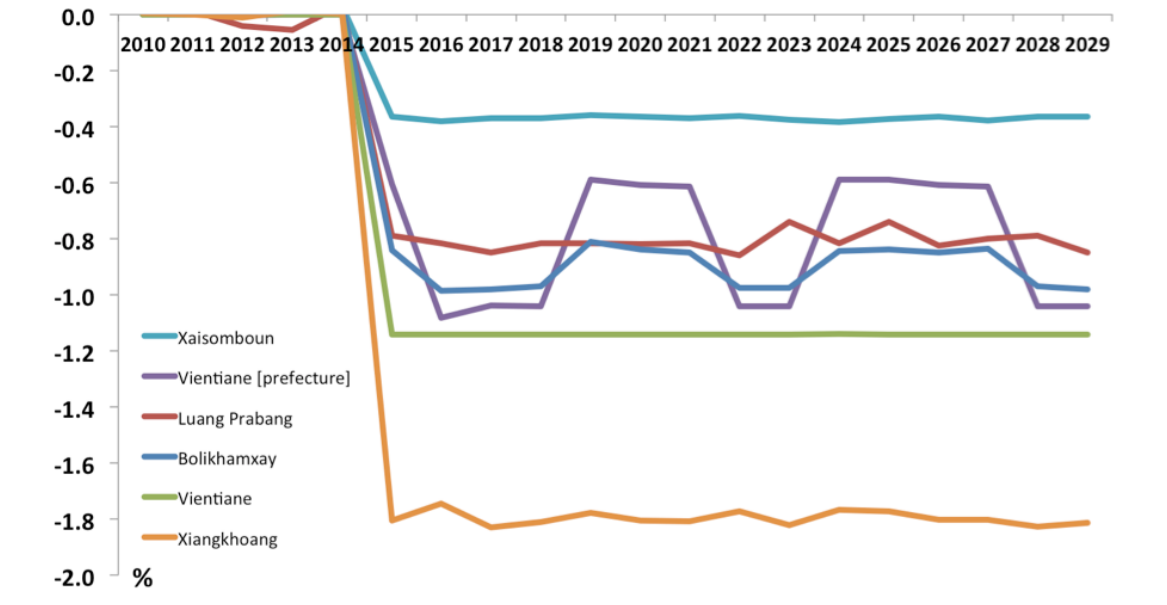
Fig. 4 . Impact of planned, large-scale irrigation infrastructure on average poverty in six provinces in the Nam Ngum Basin, Lao PDR, compared with a business-as-usual scenario. Poverty is defined as percentage of people below the official poverty line. This includes households’ income as well as their monetized subsistence production. The average is calculated across 200 model runs and across all households in each